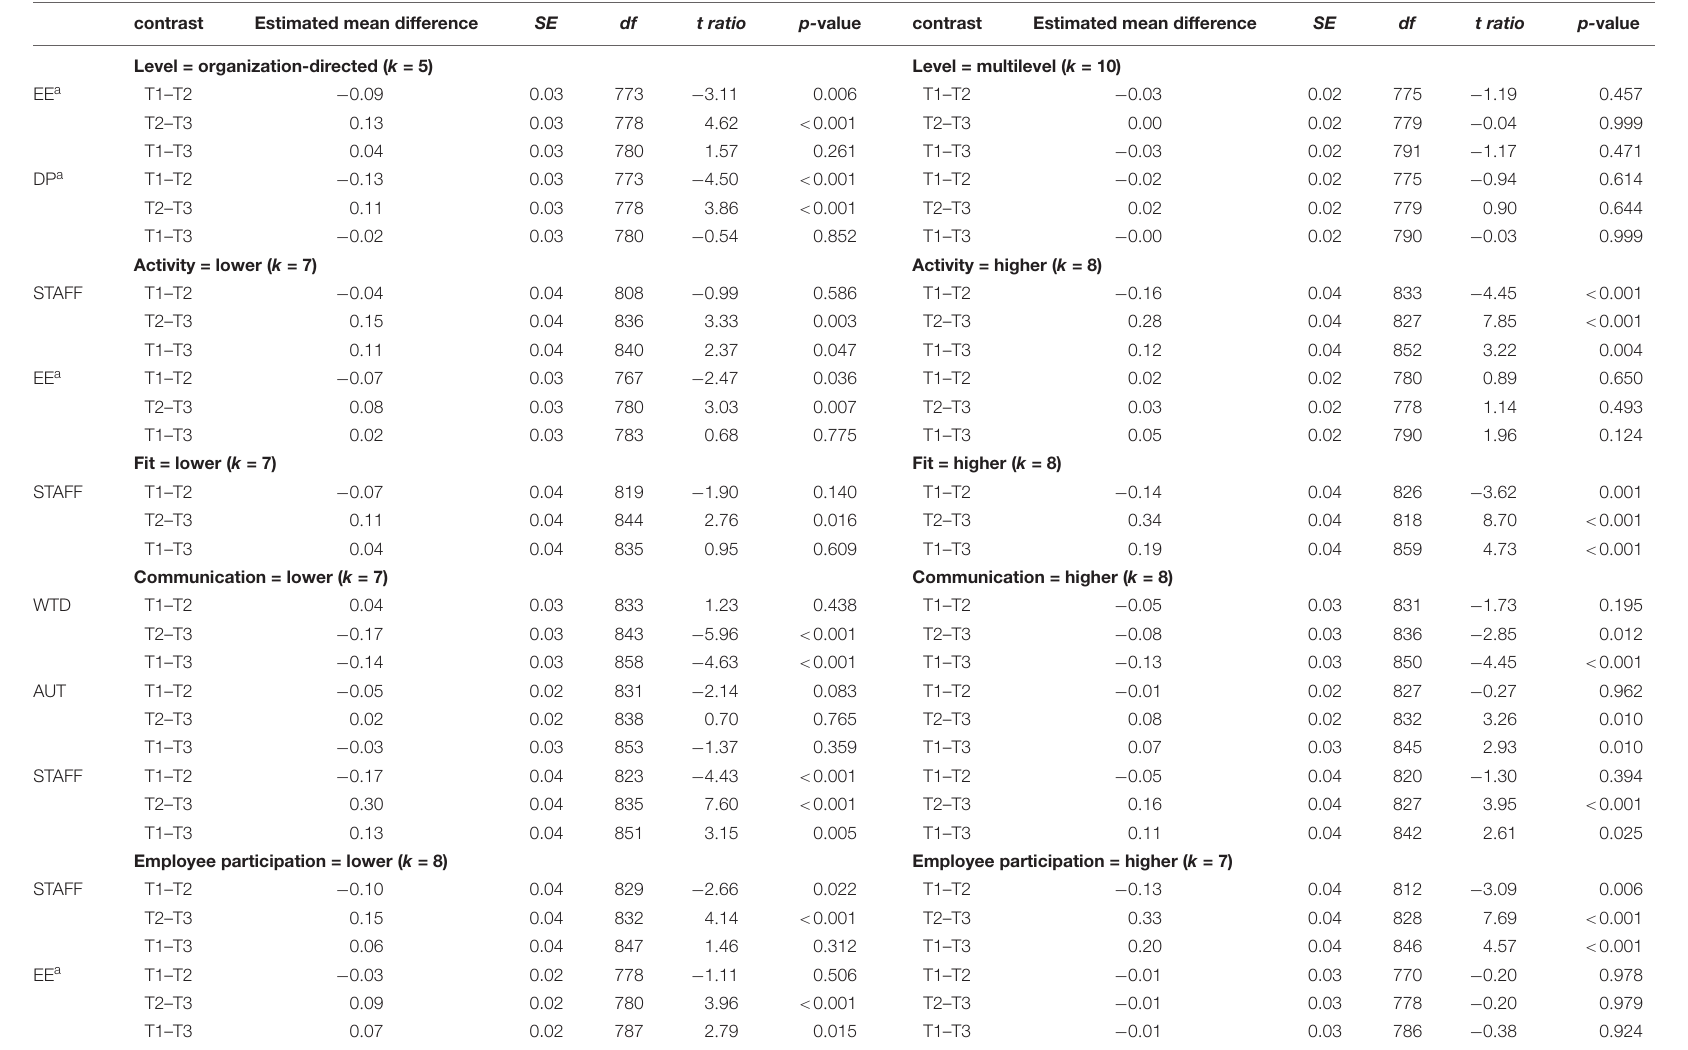
TABLE 3 | Post hoc pairwise comparisons for significant group*time